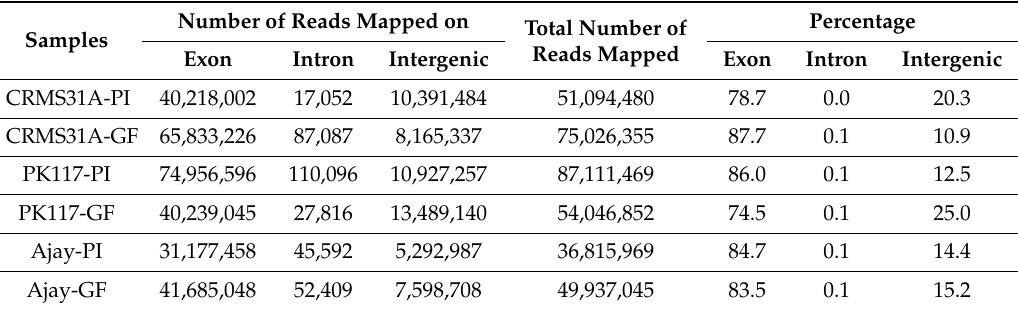
Figure 1. Differentially expressed genes (DEGs) in the rice two heterotic crosses ( A ) Ajay and ( B ) Rajalaxmi. Venn diagram of DEGs between hybrid and their parents at ( a ) panicle initiation (S1) and ( b ) grain filling (S2), PK117: IR42266-29-3R; 31A: CRMS31A; 32A: CRMS32A. Table 1. A total number of reads mapped with percentage of both panicle and grain filling stage in Ajay and its parental lines.